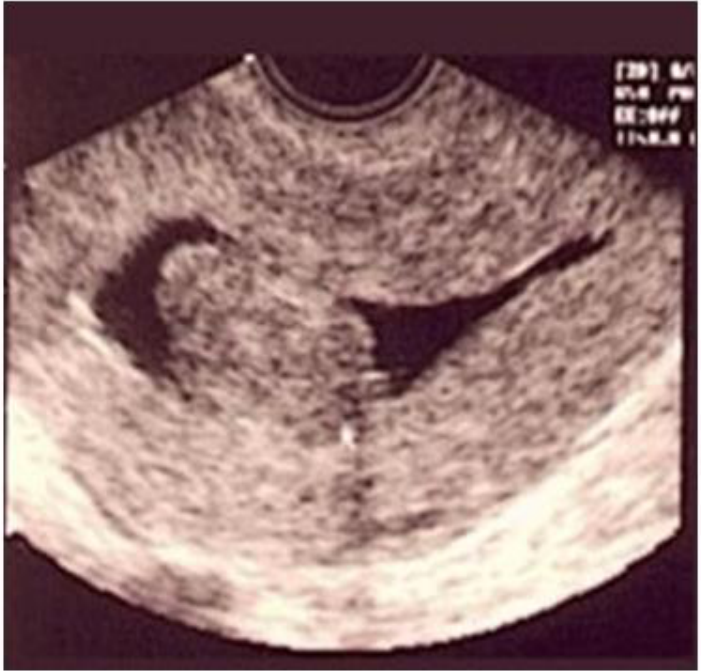
Figure 3. Submucous myoma in sonohysterography.